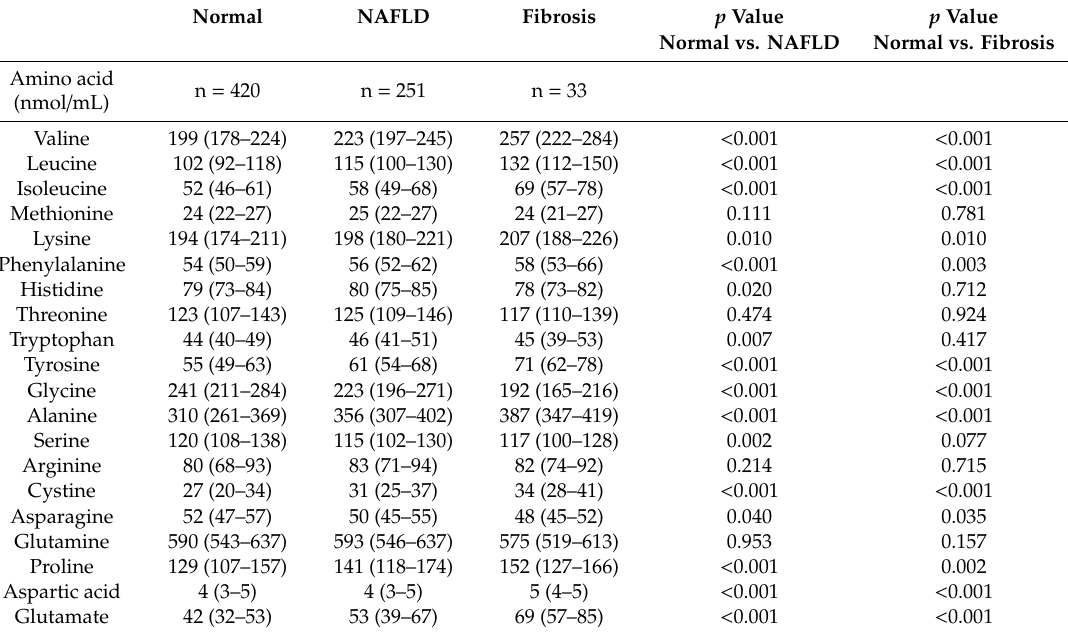
Table 2. Amino acid composition at baseline.